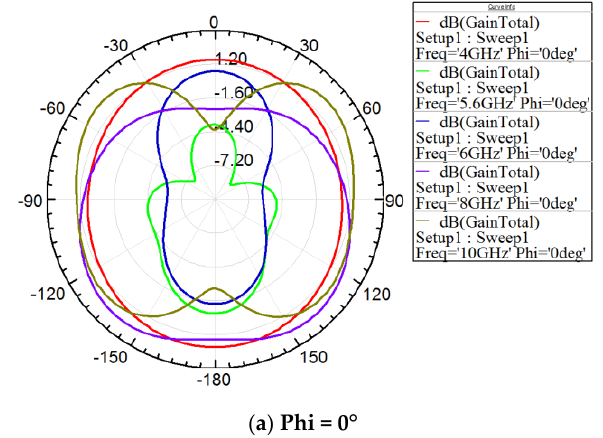
Figure 41. Antennas maximum gain with different S-SRR arrays.